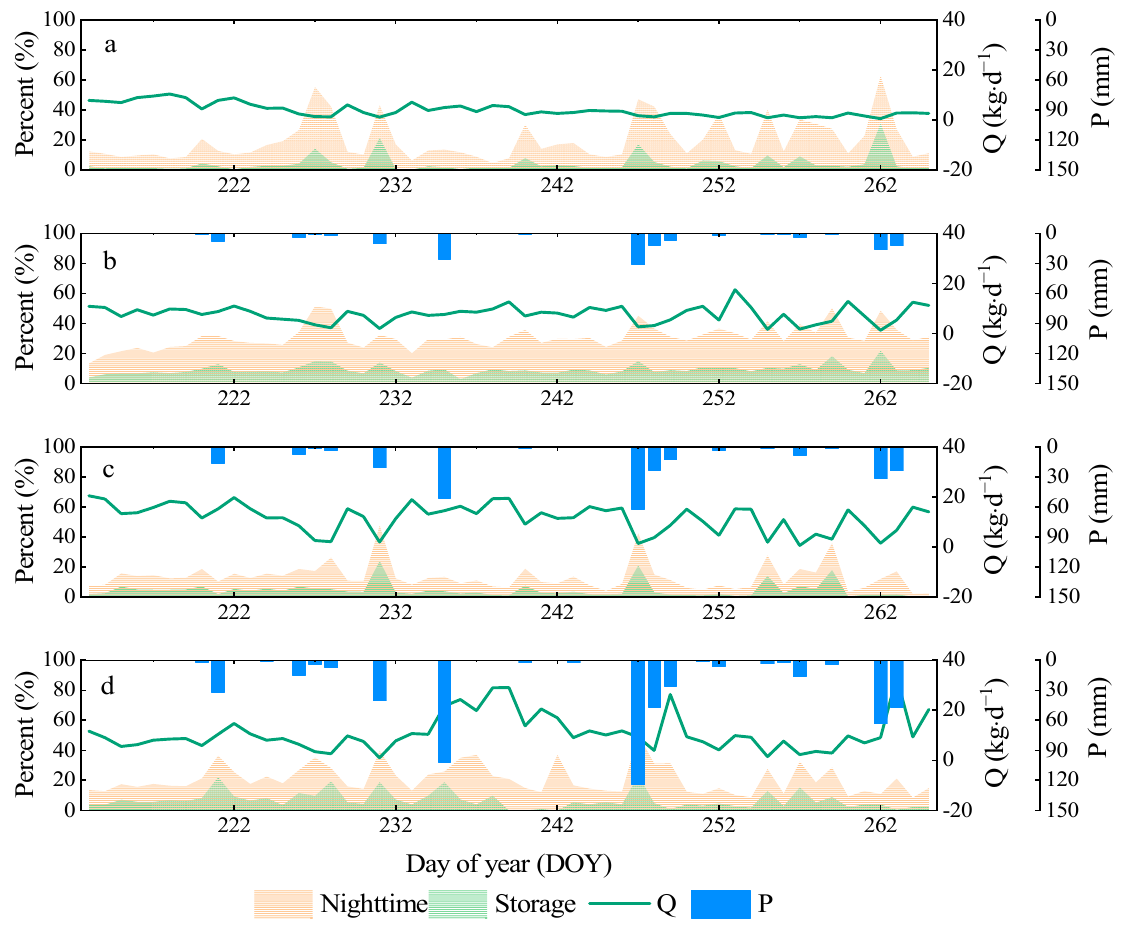
Figure 6. Variation of daily sap flow (Q), nocturnal sap flow percentage (NQ), water storage percentage (WS), and precipitation (P) under the four treatments. ( a ) NR treatment. ( b ) HR treatment. ( c ) AR treatment. ( d ) DR treatment.